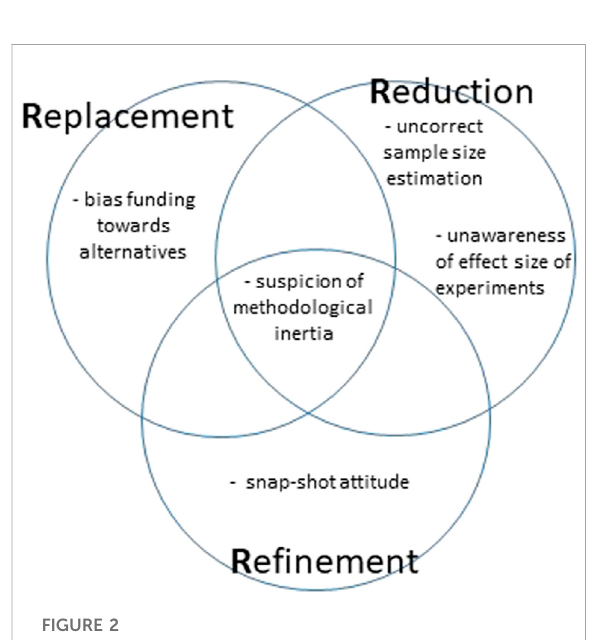
FIGURE 2 Potential issue troubling a correct application of the 3Rs